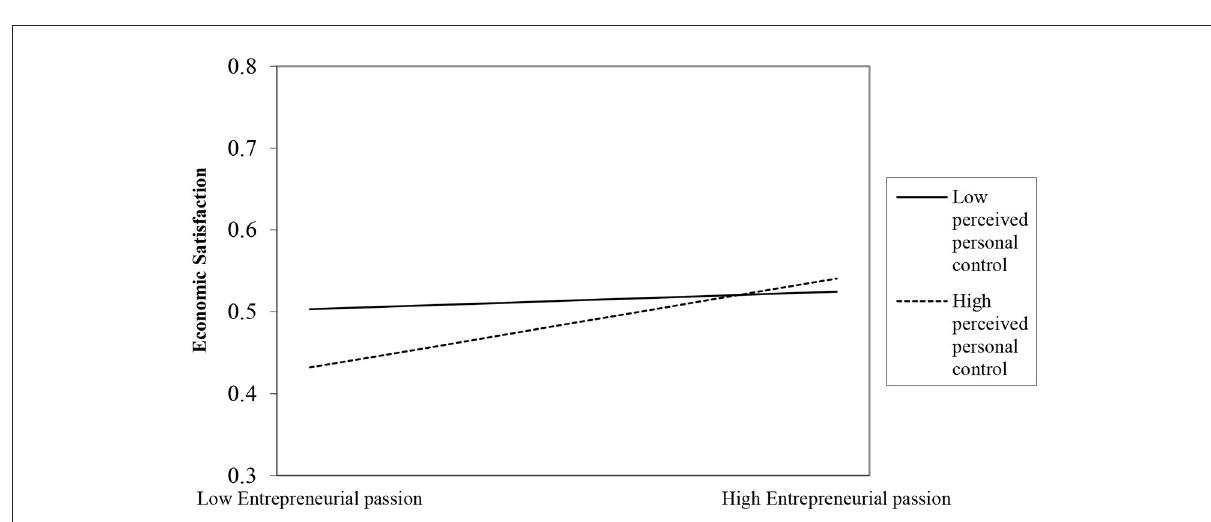
FIGURE3 The moderating effect of perceived personal control on entrepreneurial passion and economic